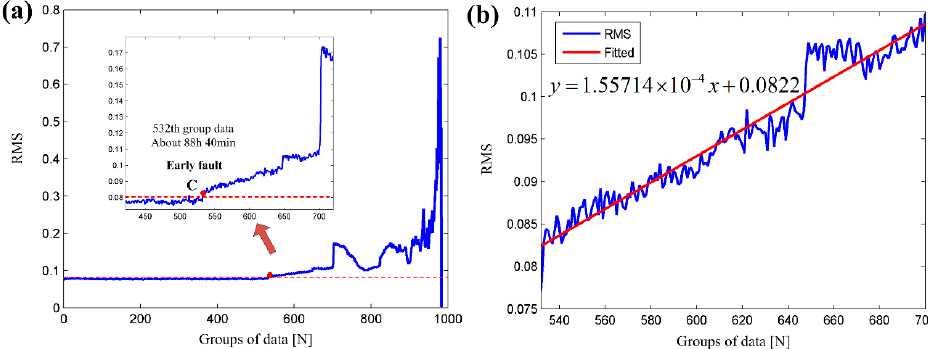
Figure 20. The discrete probability distribution for parameters at the stationary stage: ( a ) ACFHNR; ( b ) root-mean-square (RMS); ( c ) kurtosis.